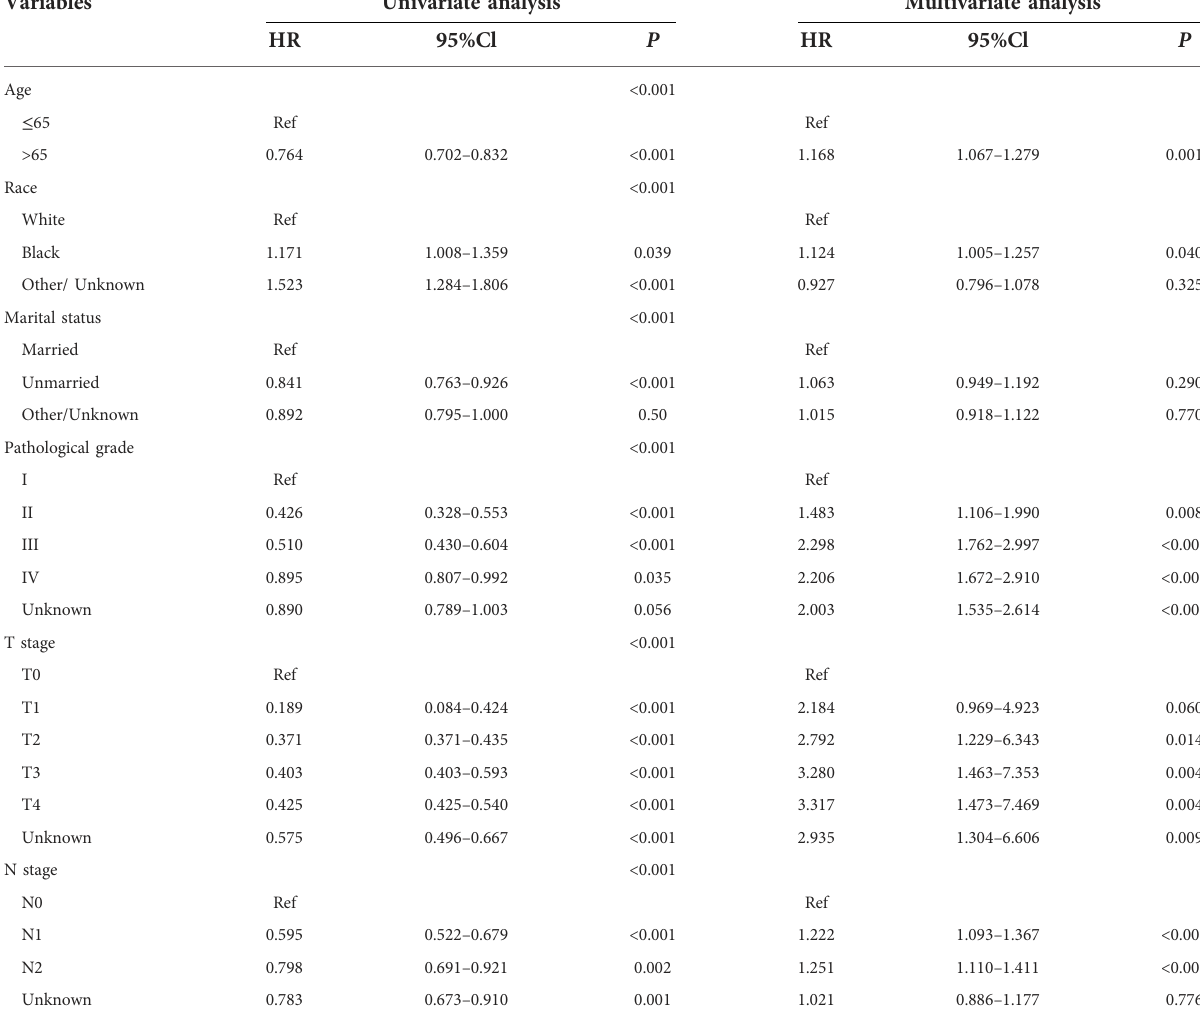
TABLE 3 Univariate and multivariate analyses of variables associated with OS in the training cohort ( n